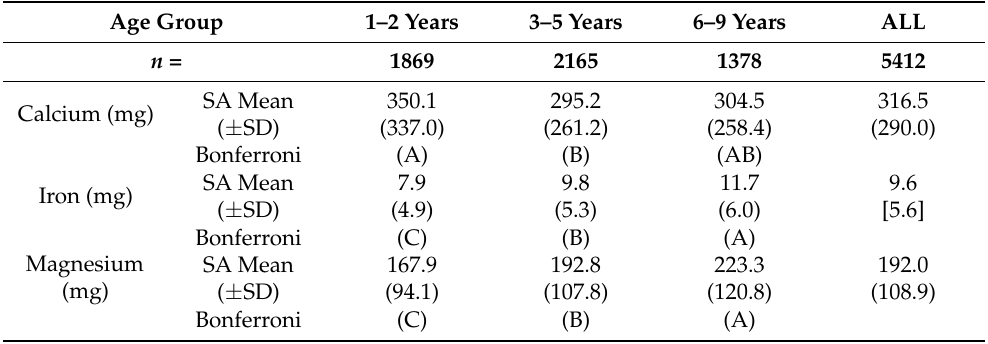
Table A2. South African child mean ± SD intake of minerals and electrolytes by PDIS age